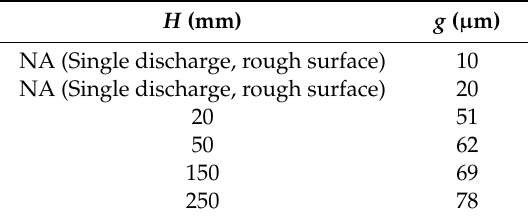
Table 4. Theoretical gap width values in the experiments.